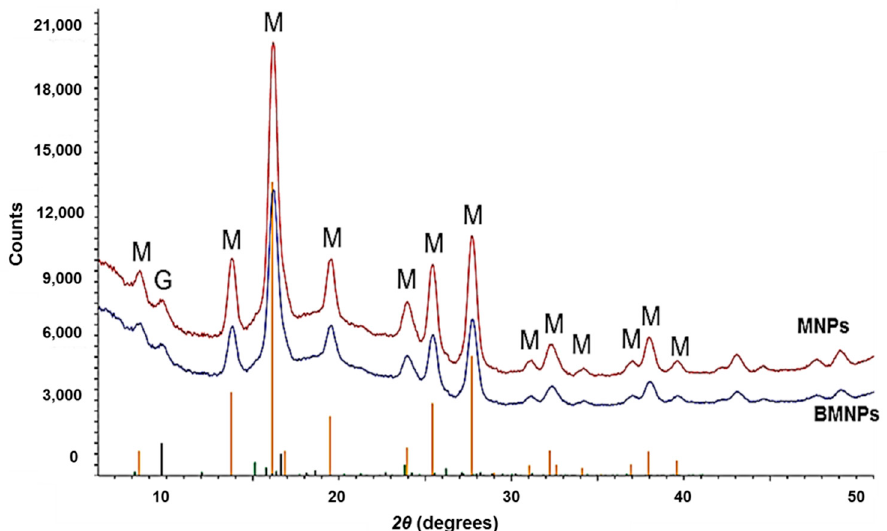
Figure 2. The XRD diffraction patterns of purely inorganic (MNPs) and biomimetic magnetic nanoparticles (BMNPs). The positions and intensities of crystallographically-pure magnetite are labeled as M, and those of goethite as G.